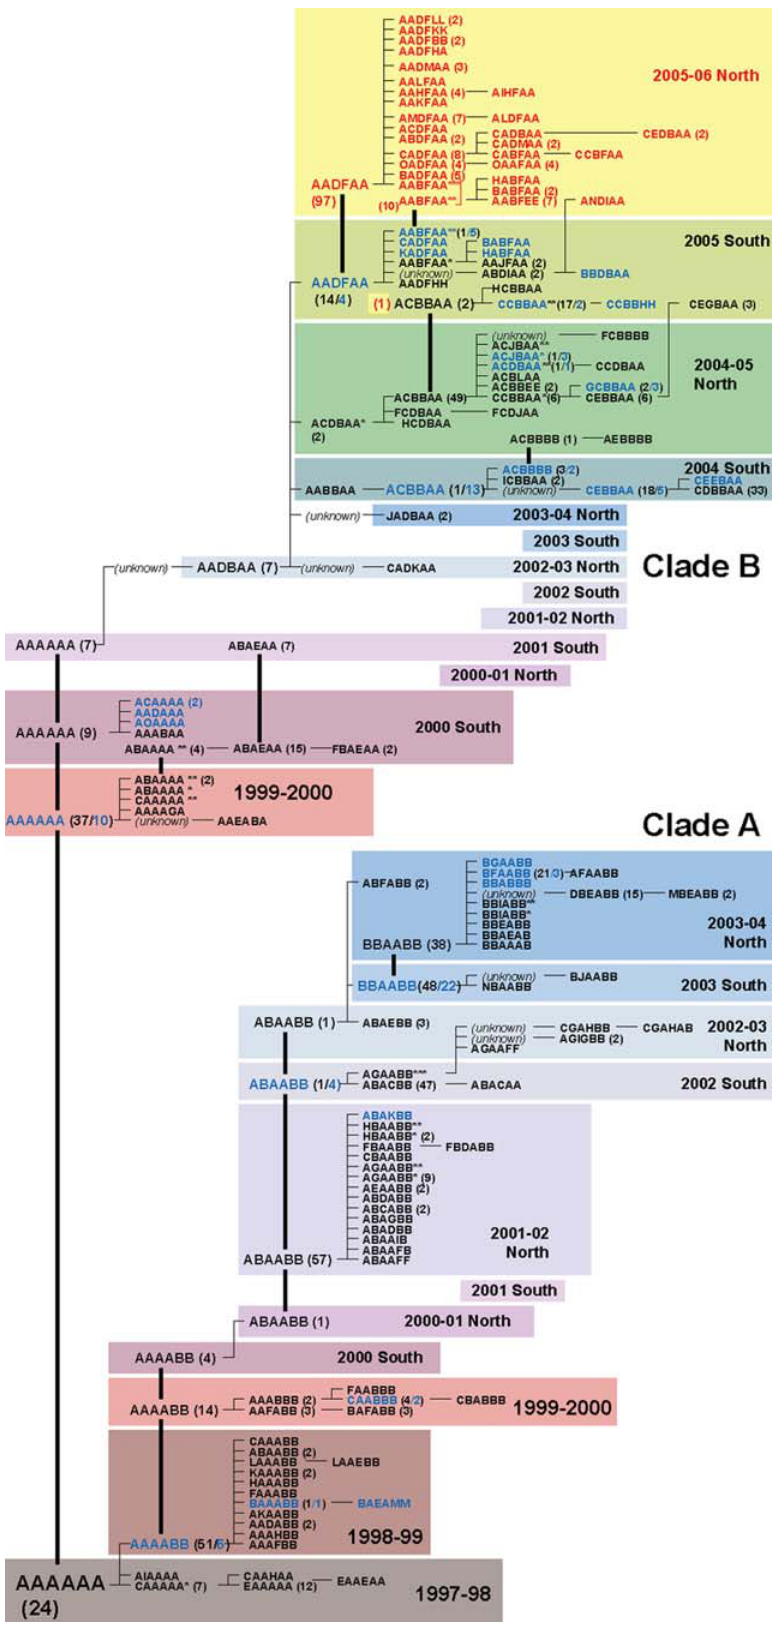
Figure 3. Clade distribution of H3N2 influenza viruses. Unique base composition types are reported using a six-letter code (see text) and are chronologically sorted bottom to top (color boxes, seasons 1997 to 2006). From year 2000 onwards, seasons were labeled ‘‘North’’ and ‘‘South’’ to reflect the northern or southern hemispheric origin of the samples. Thick vertical bars represent the persistence of main types between consecu- tive seasons. Within each season, the number of isolates is reported between parentheses for types encountered more than once. Thin horizontal lines represent the spawning of new types through the accumulation of single mutations (left to right). Black font: types determined through sequence analysis; blue font: experimentally determined base composition types; red font: experimentally determined base composition types for season 2005–06. Ten rare sequence types ( , 1.5%) were not uniquely discernable by the base composition analysis of the eight amplicons used in this analysis, as more than one subtype produced the same BC-type. These BC-types are indicated by